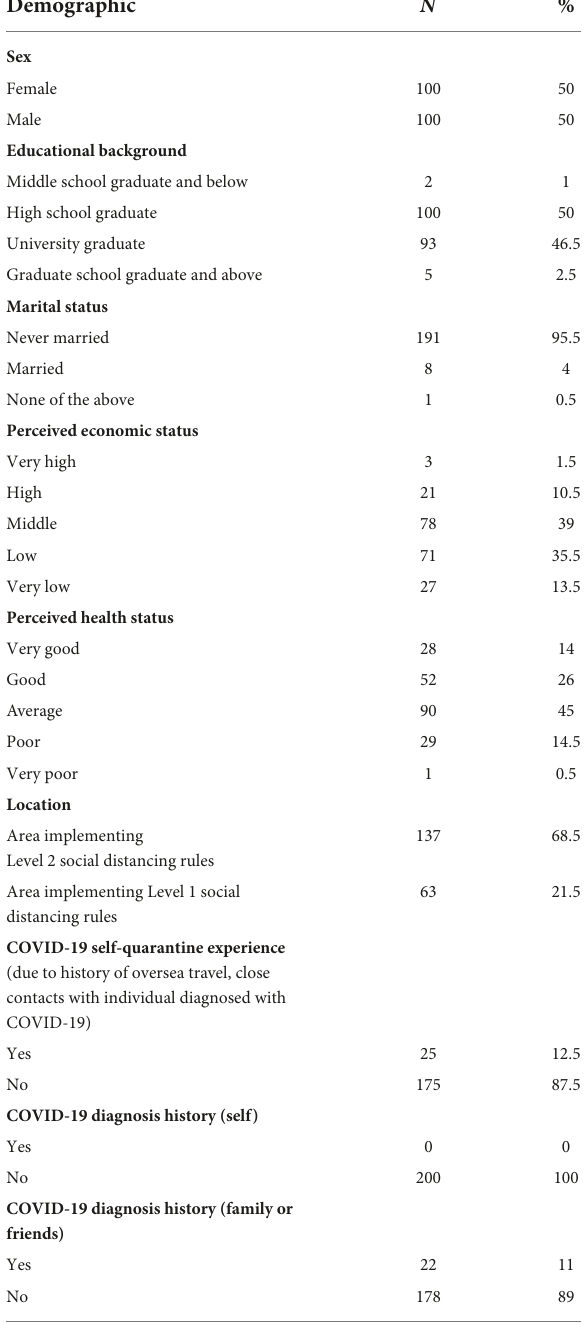
TABLE 1 Demographic information of